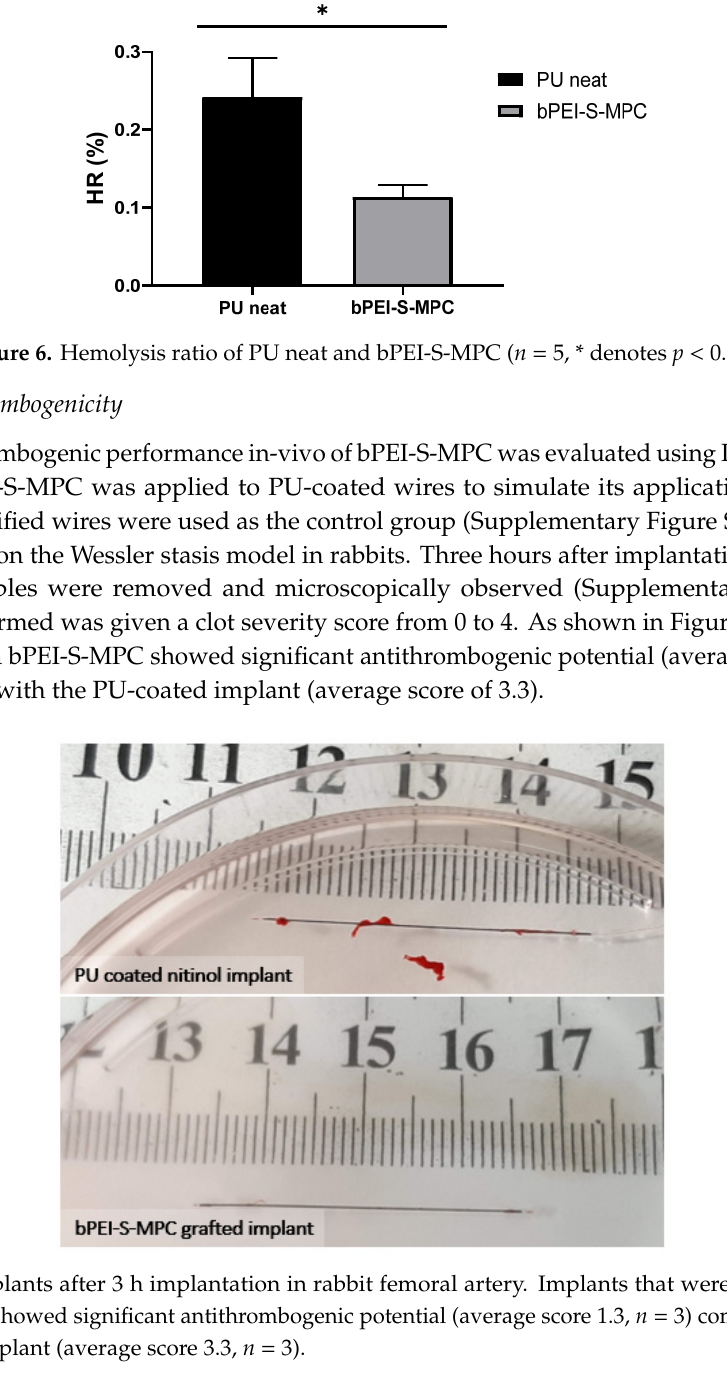
Table 3. CFU count on blood-agar Petri dishes after JIS Z2801:200 test for antimicrobial activity.